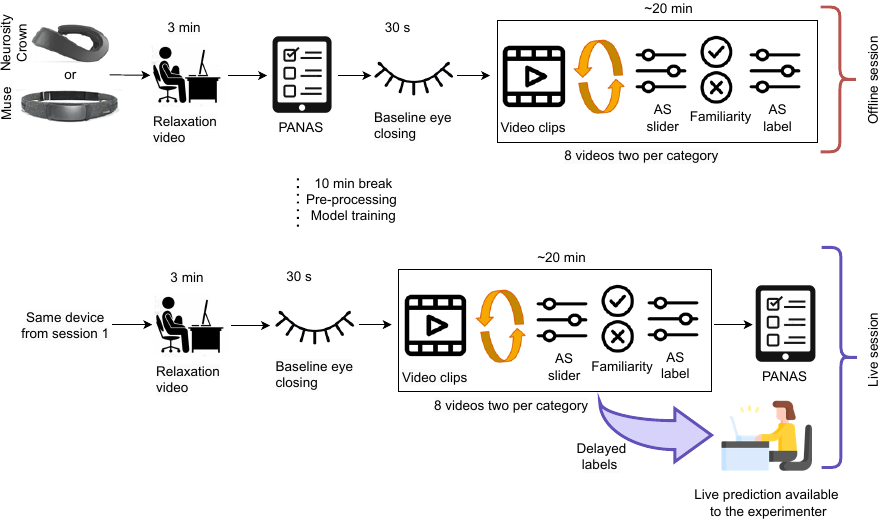
Figure 5. Experimental setup for curating Dataset III. In the first session, the participants watched a relaxation video at the beginning and eight videos, two of each dimension category wearing one of the two devices. Between the eight videos, they answered AS slider, familiarity with the video, and had seen the actual AS label. In the second session, they watched the same set of videos while the prediction was available to the experimenter before the delayed label arrived.